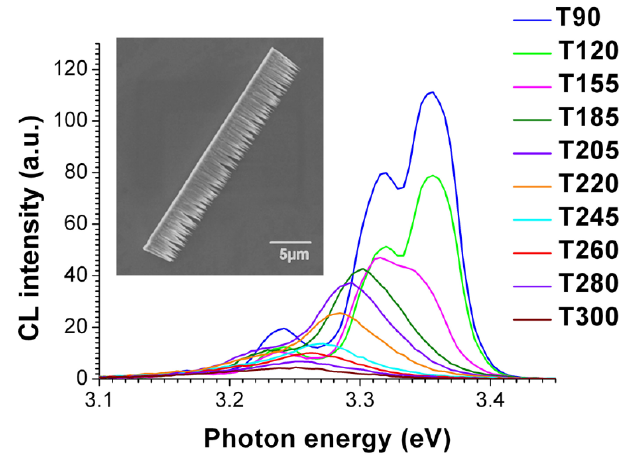
Figure 4. CL spectra measured on a comb-like structure in the temperature range from 90 to 300 K. In the inset, the SEM image of structure studied is shown.